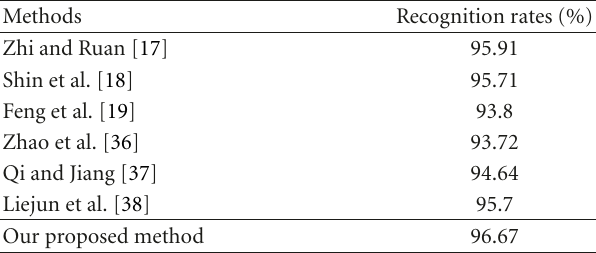
Table 2: Comparison of facial expression recognition using JAFFE